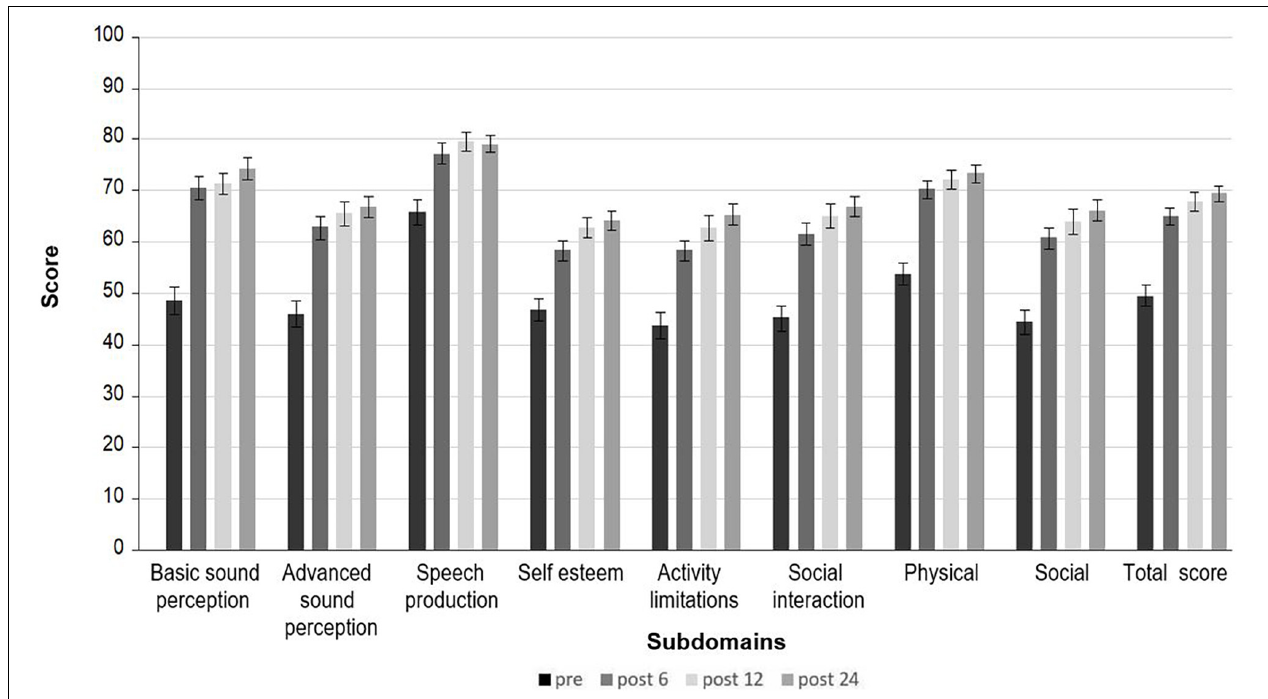
FIGURE 4 | Mean score of the Nijmegen Cochlear Implant Questionnaire. Preoperatively and 6, 12, and 24 months after cochlear